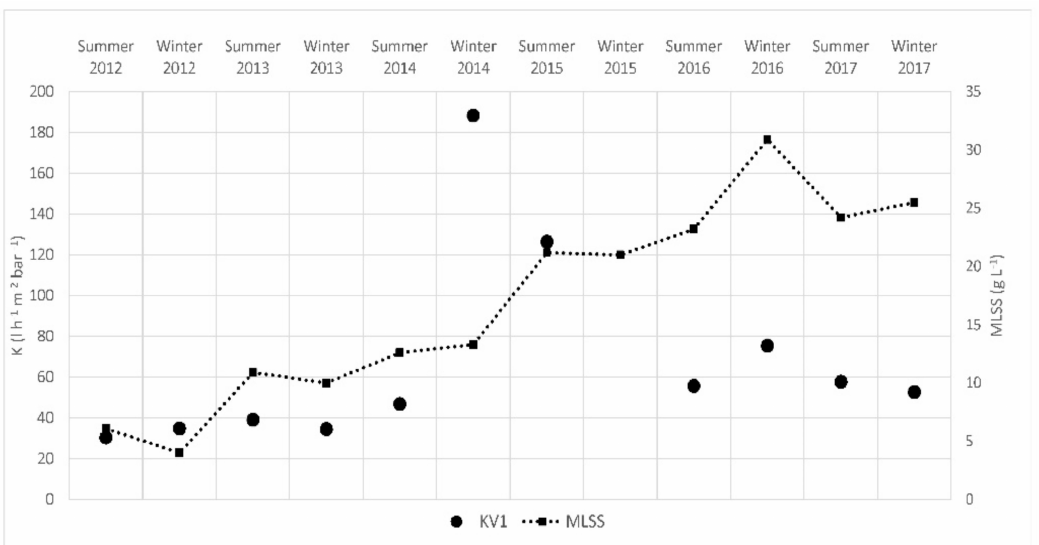
Figure 7. Permeability (K) and MLSS from 2012 to